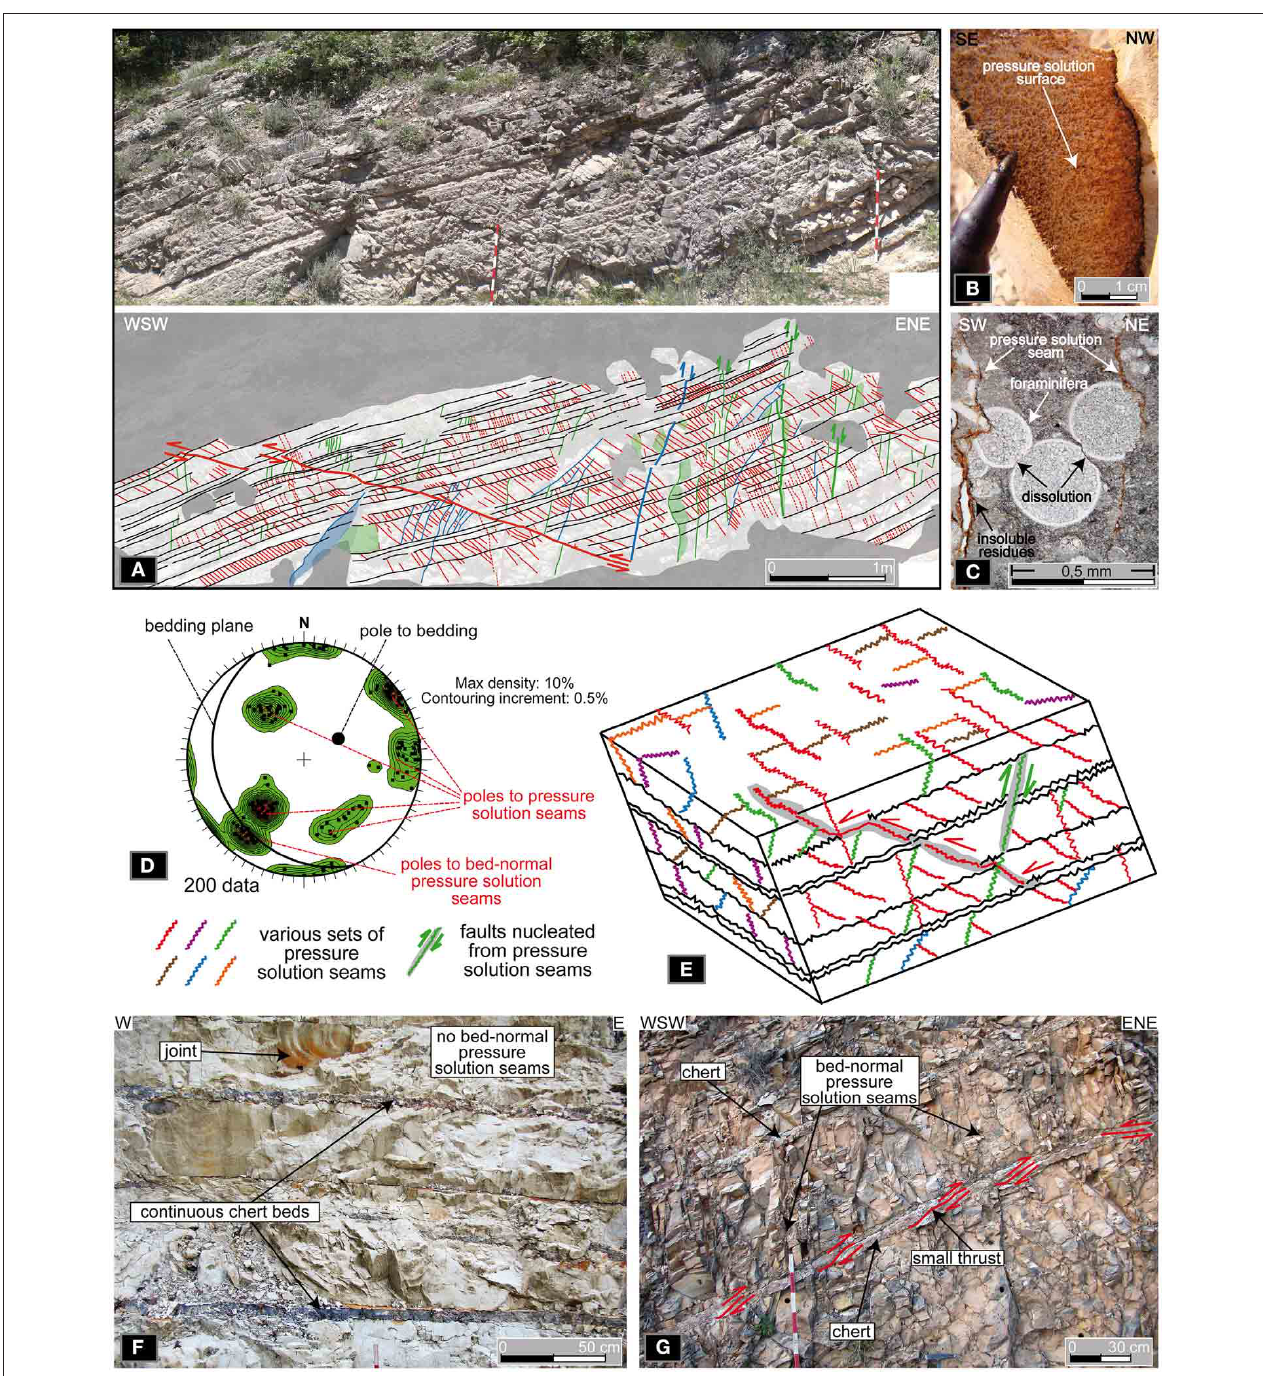
FIGURE 3 | Background data (modified after Petracchini et al., 2012, 2015). (A) Photograph (above) and line drawing (below) of marly carbonate beds (Scaglia Rossa Fm.) dipping toward the south-west in the Cingoli anticline backlimb. The beds are affected by numerous sets of pressure solution seams including bed-normal ones developed during the layer-parallel-shortening (early thrusting) phase. (B) Photograph of a stylolitic surface of one of the bed-normal pressure solution seams shown in the previous photograph. (C) Micro-photograph displaying two of the bed-normal pressure solution seams shown in the previous photograph. Note the dissolution of fossils and other features across the seams. (D) Schmidt net (lower hemisphere, produced with the Open Plot software by Tavani et al., 2011) and (E) block diagram of the Cingoli anticline backlimb showing the attitude and conceptual distribution of the main sets of pressure solution seams. (F) Photograph of sub-horizontal carbonate and chert beds (Scaglia Bianca Fm.) from the Cingoli anticline. Due to the strengthening effect of the chert beds, these beds are not affected by contractional deformation such as bed-normal pressure solution seams and reverse faults. (G) Photograph of inclined carbonate and chert beds (Scaglia Rossa Fm.) from the Cingoli anticline. The chert beds are, in places, broken and affected by small thrusts. Correspondingly, in the carbonate beds, some bed-normal pressure solution seams developed.